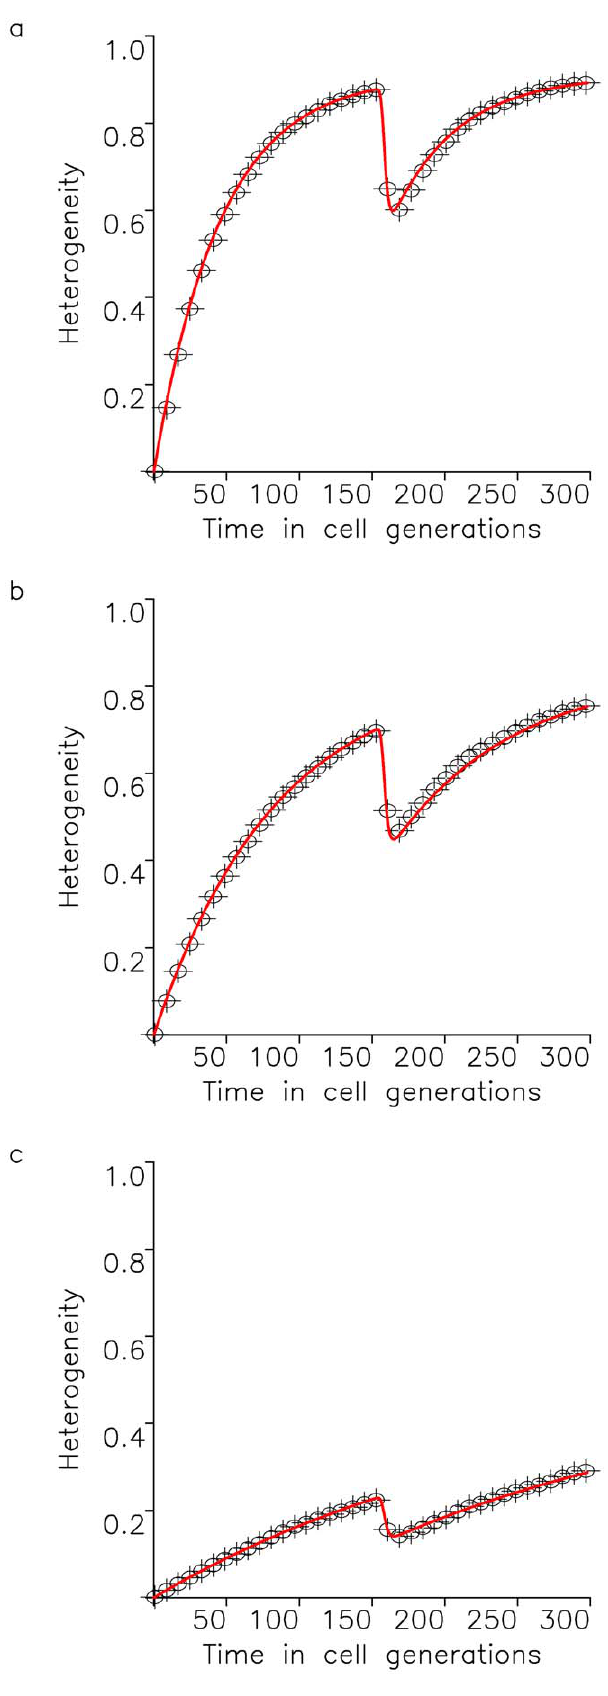
Figure 4. Tumor heterogeneity when only neutral variation can be detected. A cell population of fixed size, N , accumulates neutral mutations at rate u per cell division. All neutral mutants have growth rate R and death rate D . Additionally, a positively selected mutant arises at time t 1 in the population. Its lineage has growth rate R z S and death rate D . This mutation, however, cannot be detected when measuring heterogeneity in the population. The figure shows the fit of the exact stochastic computer simulation of this process with equation (12). In the simulation, heterogeneity is defined as Simpson’s index, equation (1), and wild type cells as well as cells harboring the advantageous mutation are considered as one cell type. Parameters are N ~ 1000 , R ~ D ~ 1 , I ~ 10 4 , u ~ 10 { 2 , and S ~ 1 in (a), S ~ 3 in (b), and S ~ 100 in (c), and results are averaged over 1000 simulation runs.